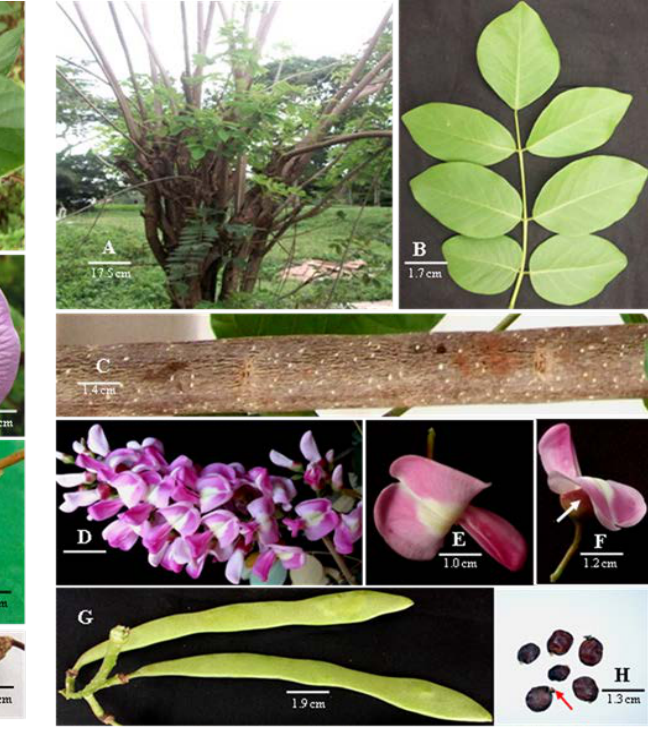
Fig. 9. Morphology of Centrosema molle Mart. ex. Benth. Fig. 10. Morphology of Gliricidia sepium (Jacq.) Walp. Table 1. Summary of the qualitative morphological traits of the studied species of the subfamily Papilionoideae Species